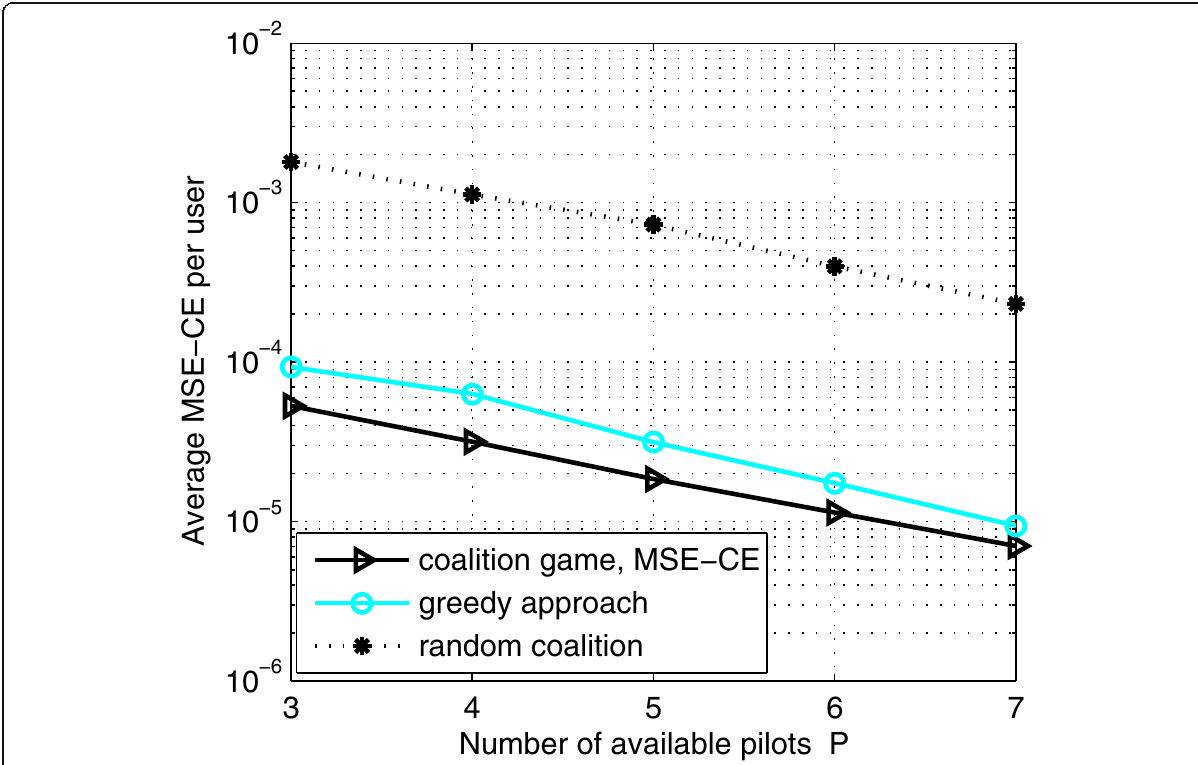
Fig. 6 Average MSE-CE versus the number of available pilots P with T = 20 dBW